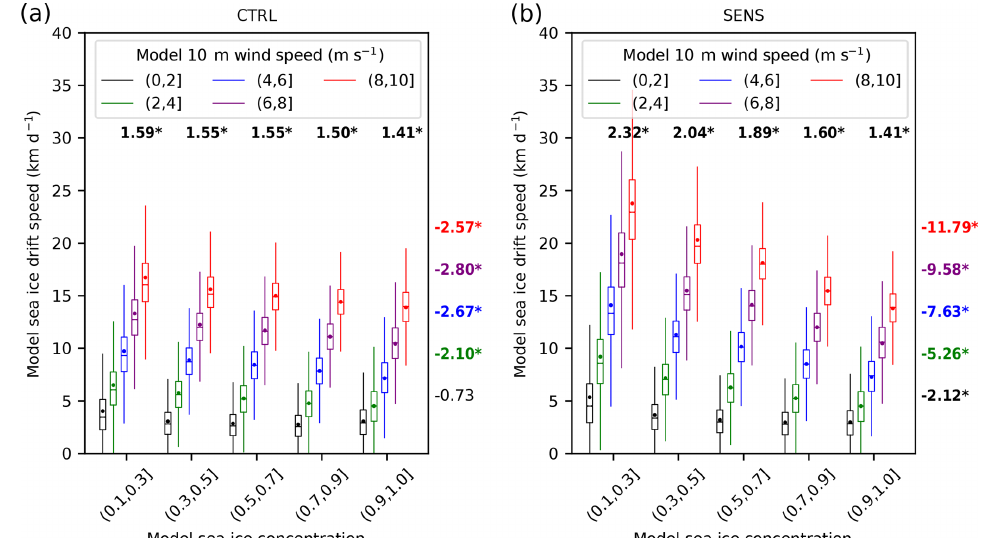
Figure 9. Box–whisker plots of the relationship between sea ice drift speed and sea ice concentration for different near-surface wind speed classes (different colors) for the 2007 summer (JJAS) in the (a) CTRL and (b) SENS experiment. The plot is based on daily data and on all grid points within the study domain indicated in Fig. 1. The horizontal bar represents the median, the notch represents the 95% confidence interval of the median, the dot represents the mean, the top and bottom of the box represent the 75th and 25th percentiles, and the upper/lower whiskers represent the maximum/minimum value within 1.5 times the interquartile range (IQR) to 75th/25th percentiles. The numbers above the boxplots represent the slopes of near-surface wind and sea ice drift speed fit lines (unit: kmd − 1 per 1ms − 1 wind speed change; font colors as for the wind speed classes). The numbers right of the boxplots represent the slopes of sea ice concentration and sea ice drift speed fit lines (unit: kmd − 1 per 10% sea ice concentration change). A bold and asterisked number indicates that the slope of the fit line is significant at the 95% level. In the labels of different sea ice concentration and 10m wind speed classes, “(” means exclusive and “]” means